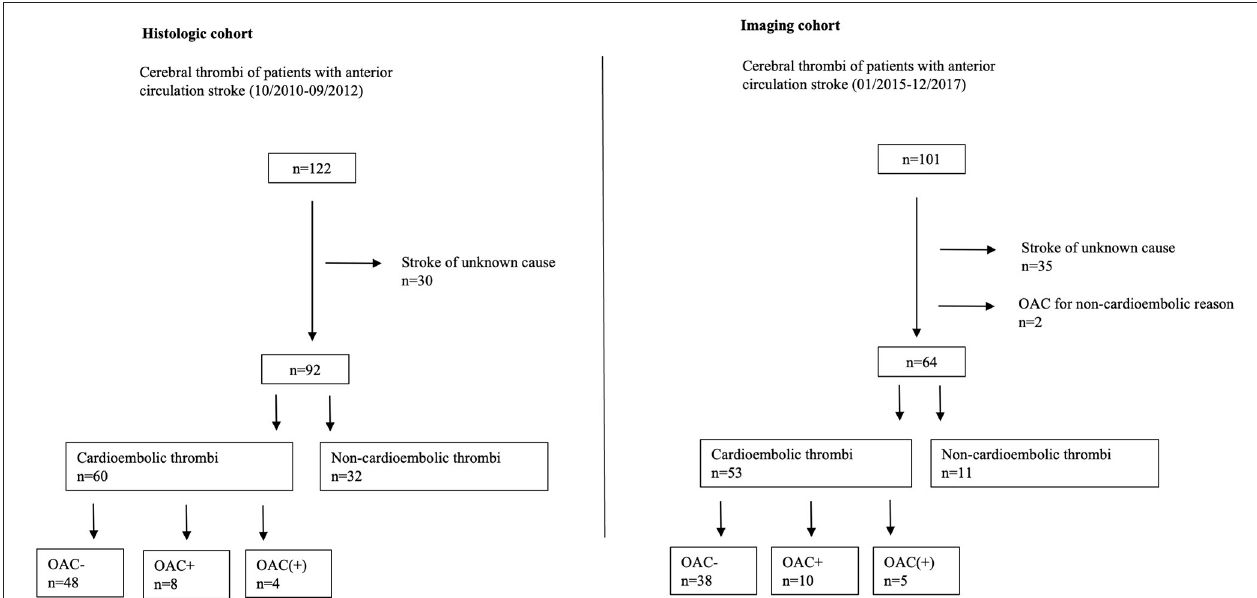
FIGURE 1 | Study flowchart. OAC– no prior oral anticoagulation. OAC( + ) prior insufficient oral anticoagulation. OAC + prior oral anticoagulation. n